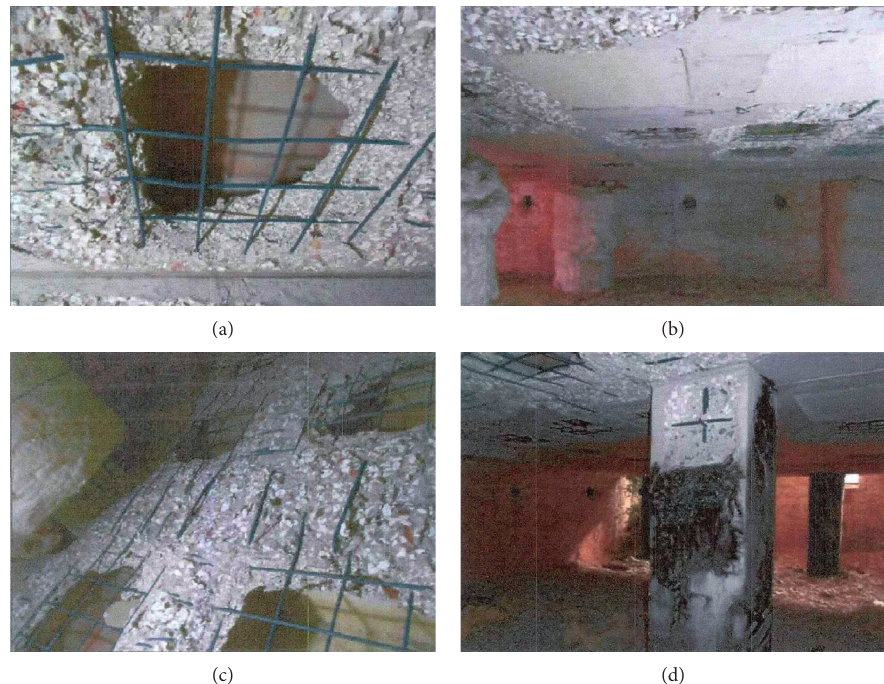
Figure 11: Concrete spalling at the bottom surface of the AMH slabs. (a) Burn through of soleplates, (b) without burn through of soleplates, (c) ribbed or frame hidden girders, and (d) column ends.